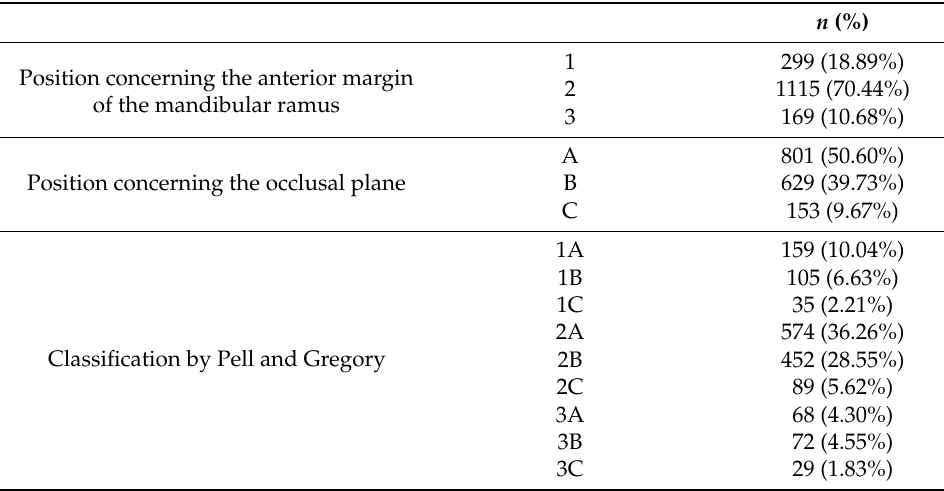
Table 4. Frequency of impaction degrees among impacted mandibular third molars according to Pell and Gregory in the study group.